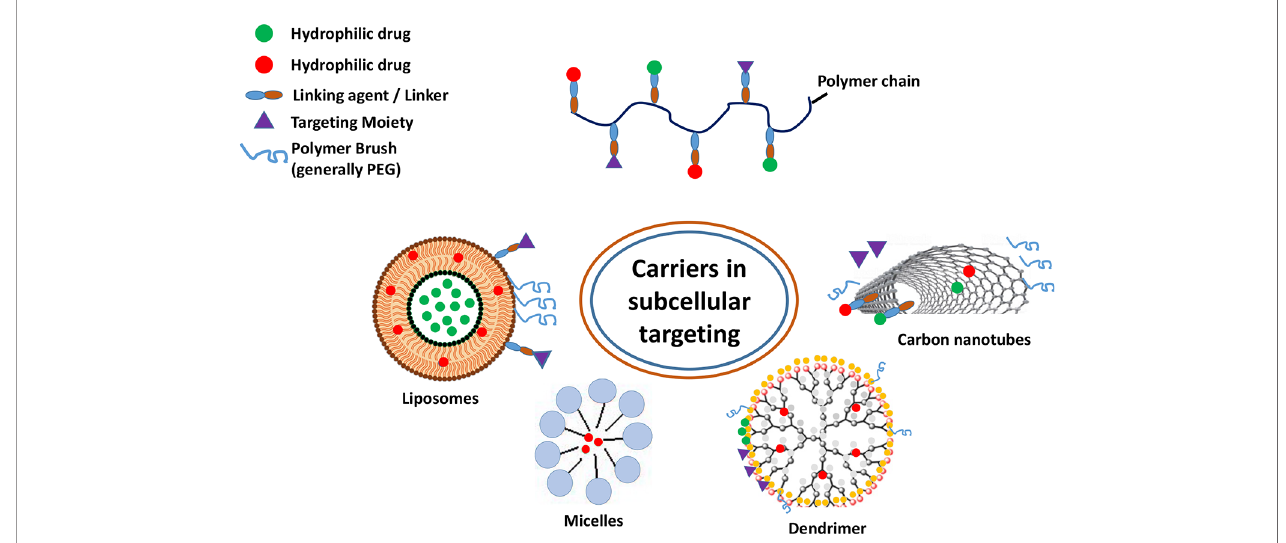
FIGURE 3 | Various carriers and their components employed in subcellular targeting. The nanocarriers are composed of hydrophobic and/or hydrophilic polymeric chains capable of encapsulating and delivering both kinds of therapeutic